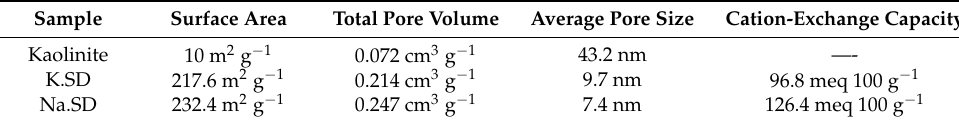
Table 2. The textural properties of kaolinite, K.SD, and Na.SD.